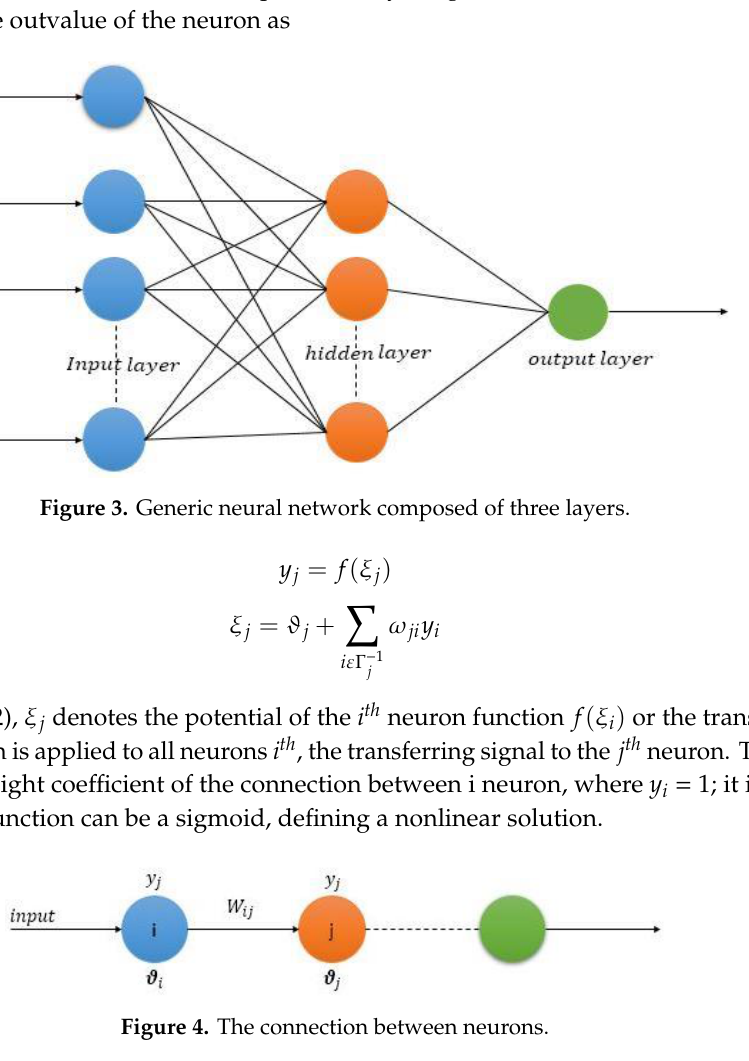
Figure 4. The importance of the neuron is represented by weights that have a connection in the model.